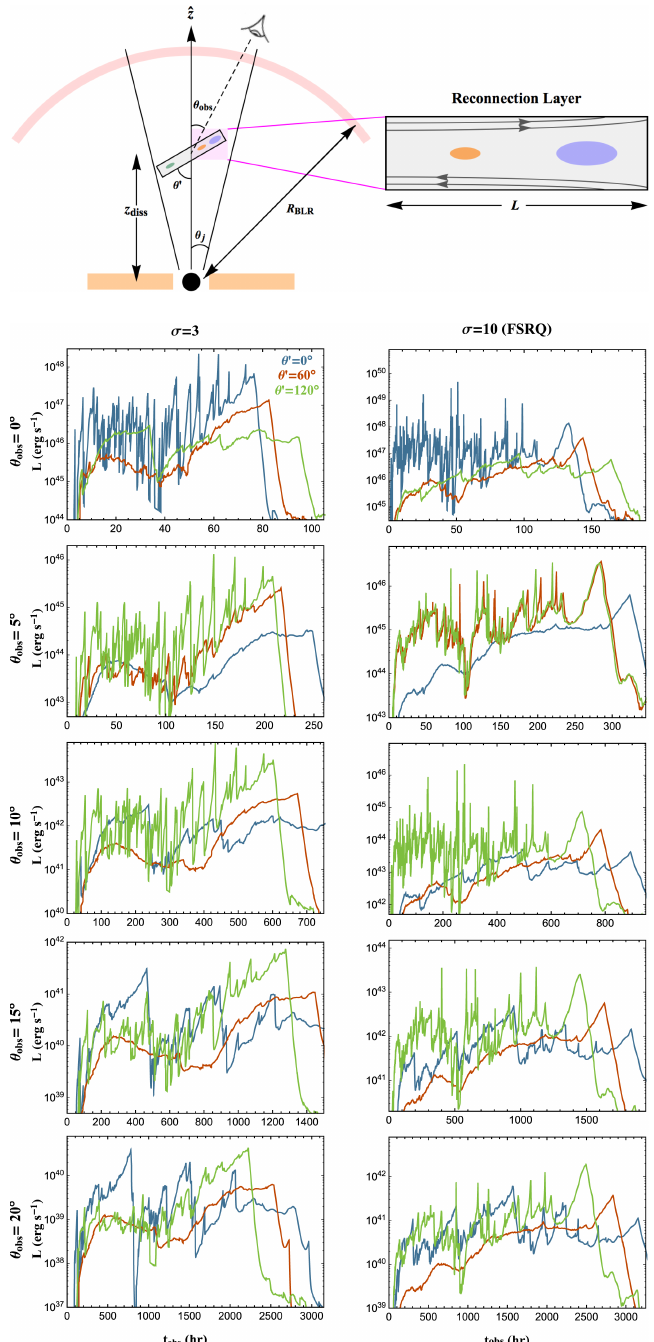
Figure 11. Top : Sketch of a jet-in-a-jet scenario where particle acceleration results from pasmoid-dominated magnetic reconnection. Bottom : Simulated 0.1–300 GeV γ -ray light curves at different viewing angles (top to bottom: θ obs = 0 ◦ , ..., 20 ◦ ) for two different plasma magnetization values of σ = 3 ( left ) and σ = 10 ( right ). Different colours indicate different degrees of alignment of the plasmoids with the jet axis. The light curves illustrate the rapid, large-amplitude variability that can be produced in such a scenario. From [113]. Reproduced with kind permission from Oxford University Press and the Royal Astronomical